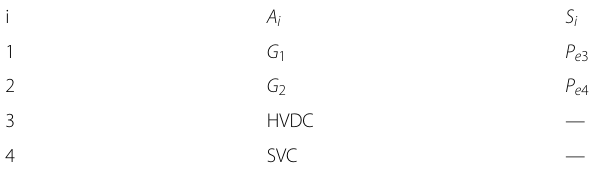
(SVC) is configured in power system and installed at bus in the centre of tie-lines. The system parameters and related details are mentioned in [20, 30]. Each genera- tor is represented by a sub-transient model and is of 5 th order with two damper windings and rated at 1000